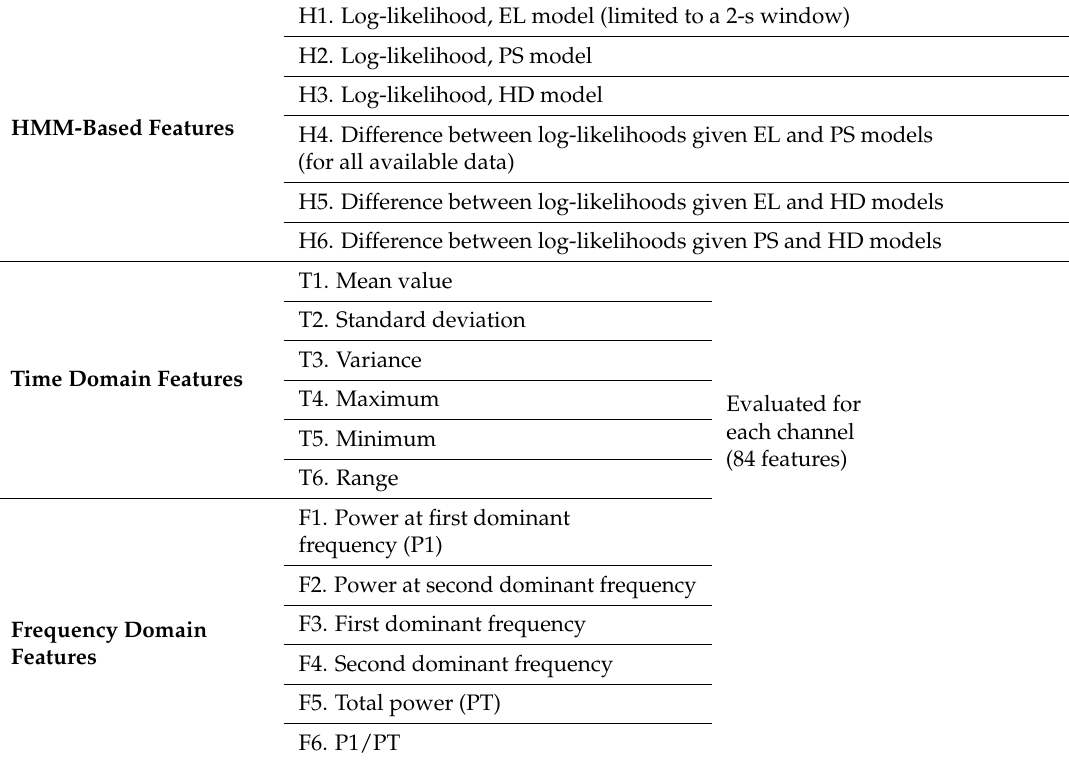
Table 1. Features for